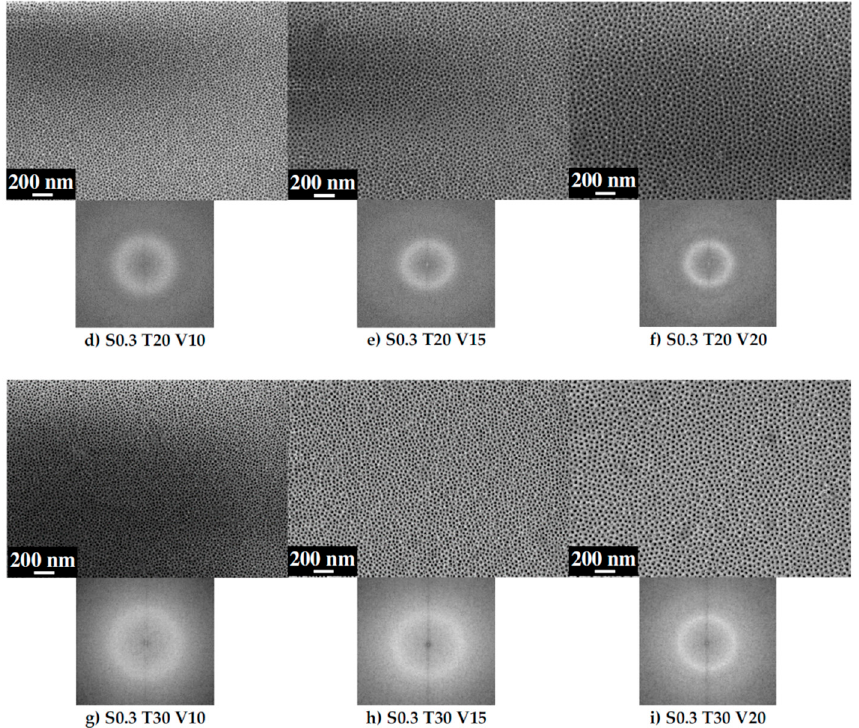
Figure 1. SEM images with their Fast Fourier Transforms of AA1050 oxide nanostructured films obtained in 0.3 M sulphuric acid and at different anodizing temperatures and voltages.